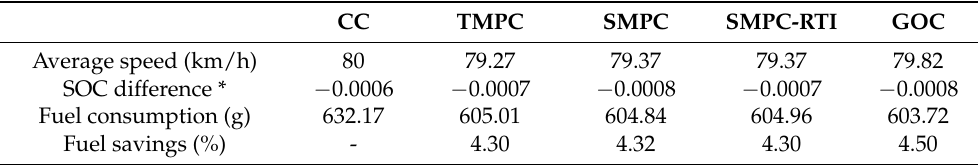
Table 6. Performance of the EC using different speed